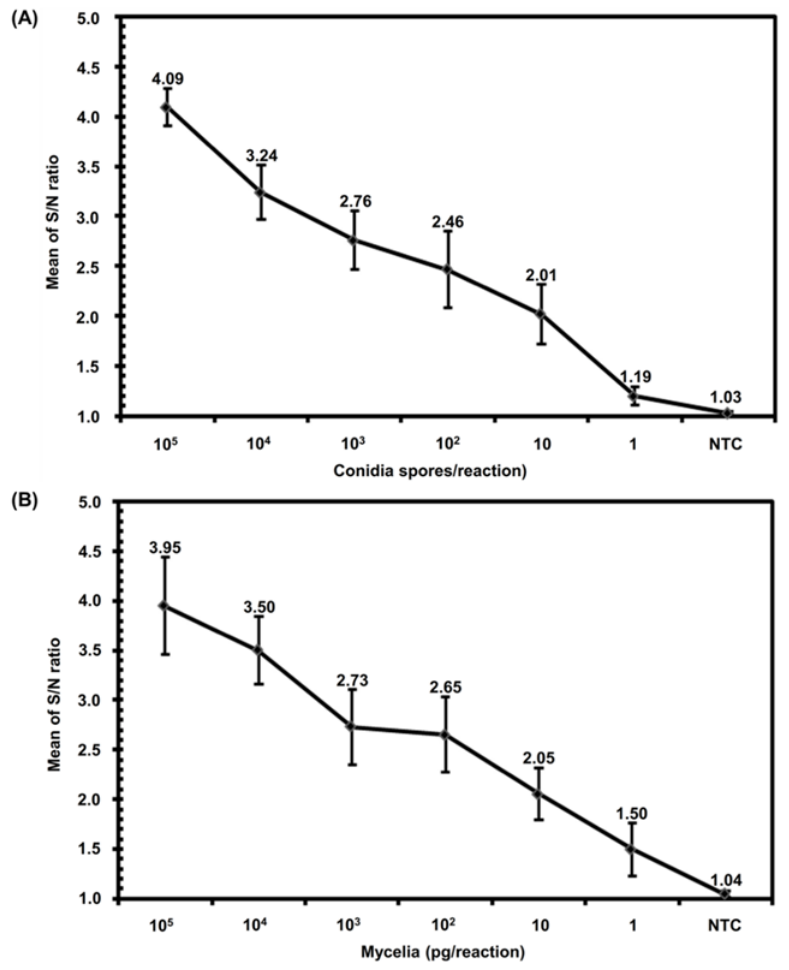
Figure 3. Direct detection of Fusarium oxysporum by insulated isothermal polymerase chain reaction assay (Fo iiPCR). ( A ) Conidia (counted with a hemacytometer under an Axioskop 2 plus microscope, ranged from 1 to 105 spores per reaction) and ( B ) mycelia (ranged from 1 to 105 pg per reaction) of Fo without DNA extraction were subjected to an iiPCR assay. The mean optical fluorescent signals (signal-to-noise (S/N) ratios) of each reaction recorded by the POCKIT™ analyzer at a wavelength of 520 nm were calculated and plotted against each input amount of conidia and mycelia. Each error bar denotes the standard deviation of the mean of seven replicate reactions.